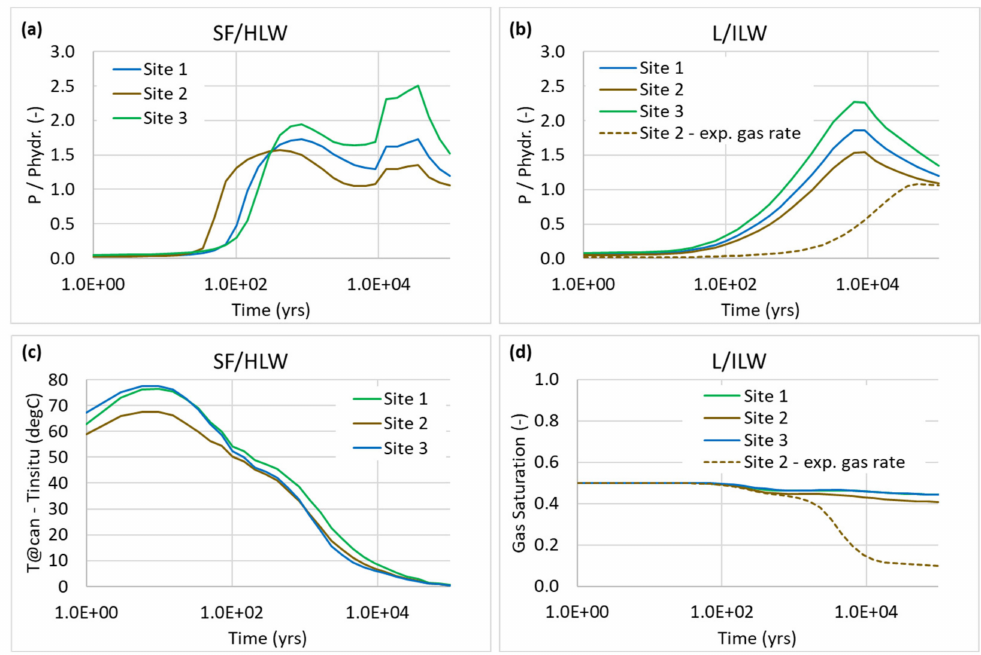
Figure 14. Example of comparison of nearfield evolution between three candidate sites: ( a ) pore pressure normalized by hydrostatic pressure at repository depth, HLW emplacement rooms; ( b ) pore pressure normalized by hydrostatic pressure at repository depth, L/ILW emplacement rooms; ( c ) tem- perature increase at HLW canister surface above in situ temperature at repository depth; ( d ) gas saturation in cementitious backfill between L/ILW